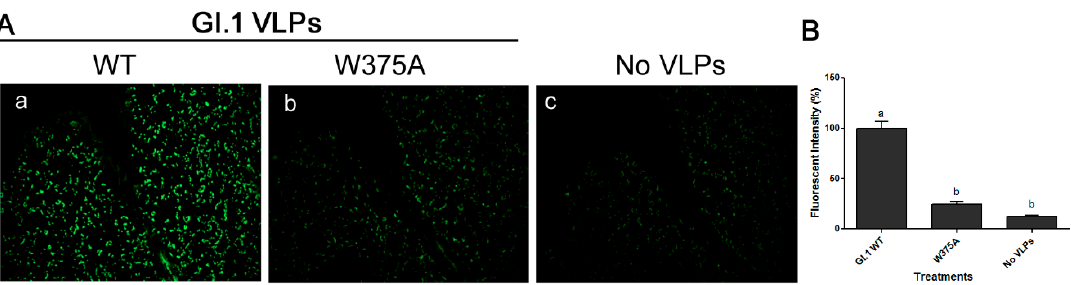
Figure 7. ( A ) Immunofluorescence assay showing the binding of (a) GI.1 WT VLPs and (b) its mutant W375A VLPs to lettuce tissue, as well as (c) control negative with no VLP added, Magnification: 40×. ( B ) Quantification of fluorescent intensity. Means with different letters differ significantly.